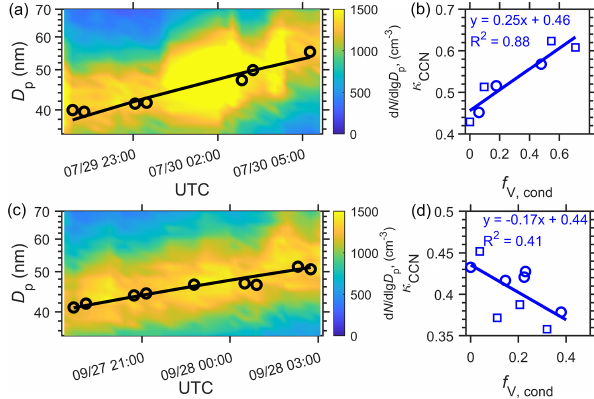
Figure 3. Examples of pre-CCN particle growth dominated by (a, b) acidic sulfates and (c, d) organics, respectively, as observed in 2017. (a) and (c) Examples of growth events identified from the time series of measured aerosol size distribution. The black circles indicate lognormal-fitted Aitken-mode diameter, and the black lines indicate the growth of the mode diameter (see Sect. 3). (b) and (d) Particle hygroscopicity κ CCN as a function of the volume fraction of condensed species in the growing particles ( f V , cond ) . f V , cond increases as particles grow by condensation. The value of κ c , CCN is derived from the variation of κ CCN with f V , cond (Sect. 3).